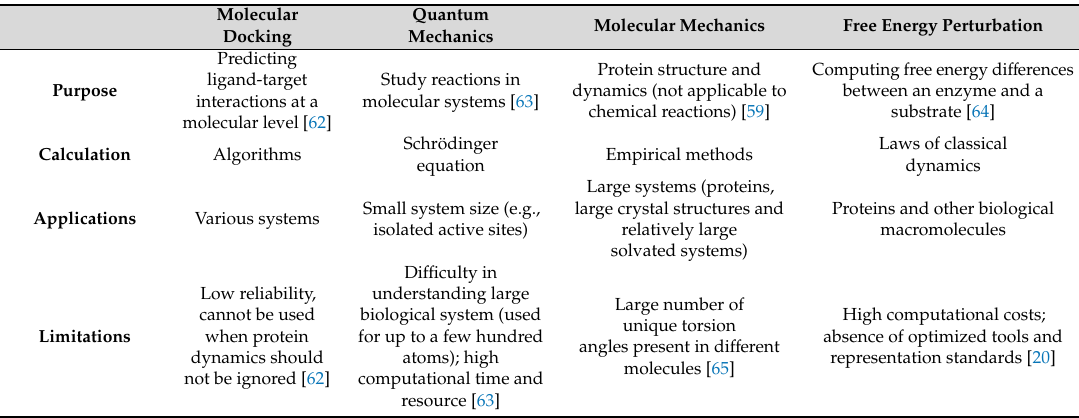
Table 1. Comparison of computational methods used in enzyme / prodrug